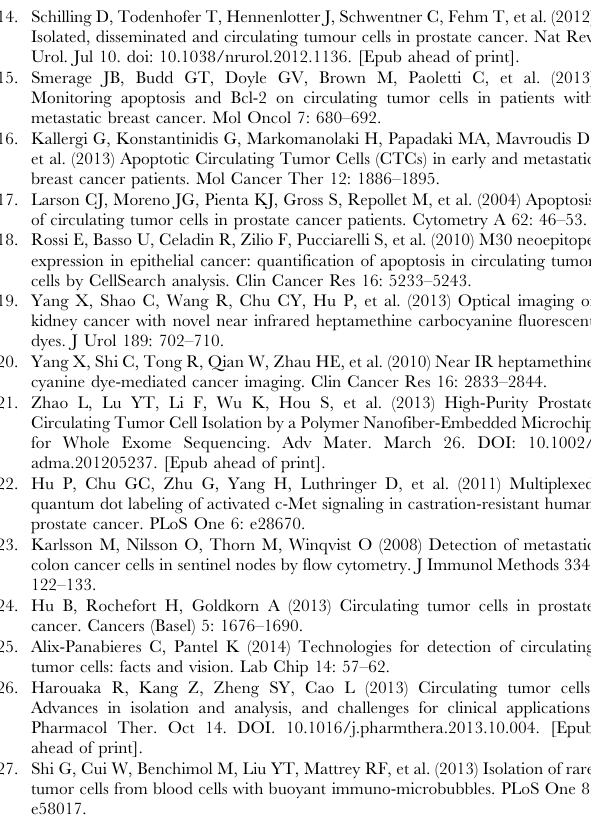
Figure S1 Confirmative staining of PC-3 cells with individual detection agents used in this study. A representative stain is shown. A, PC-3 cells stained with each individual detection agent were subjected to FACS analysis. In upper row, PC-3 cells stained by a mixture of mouse IgG1-FITC and IgG2b-PE were used as control.